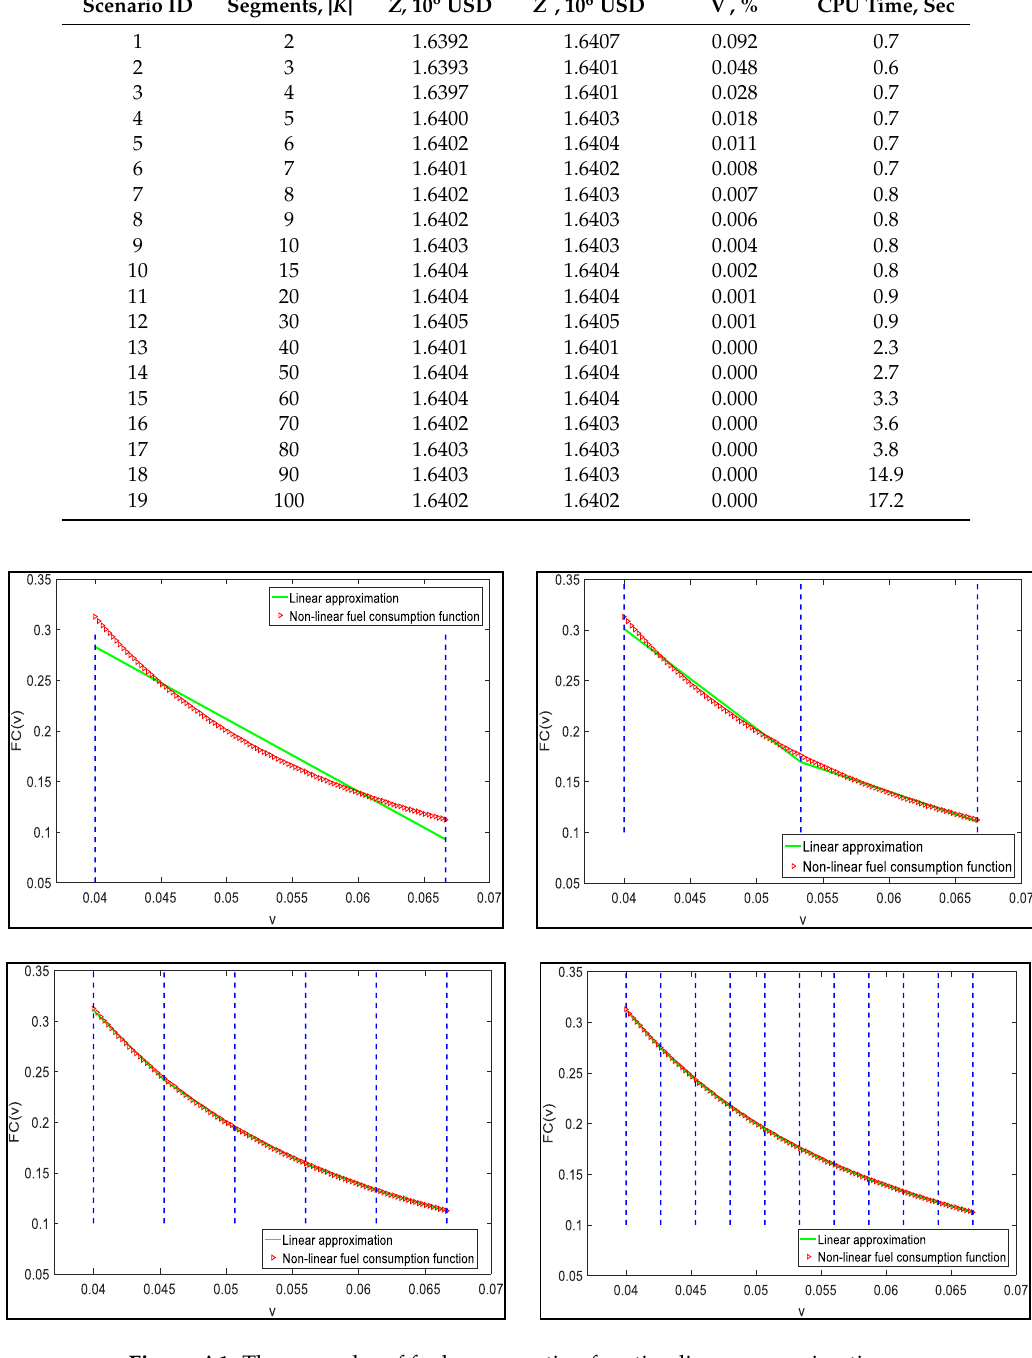
Figure A1. The examples of fuel consumption function linear approximations.